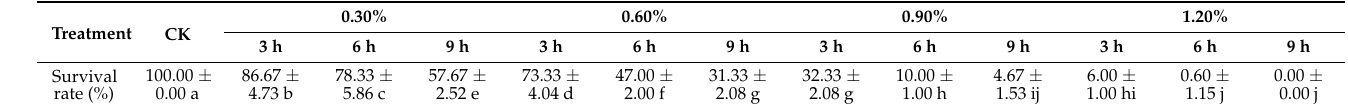
Table 1. The survival rate of apical meristem treated with EMS at different concentrations and duration in F. nilgerrensis